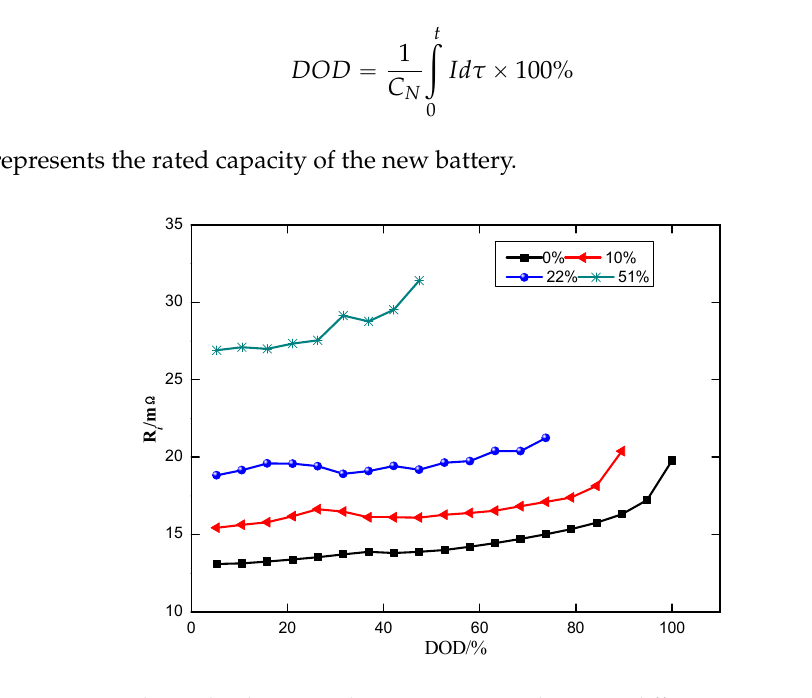
Figure 3. Relationship between ohmic resistance and DOD at different aging states.